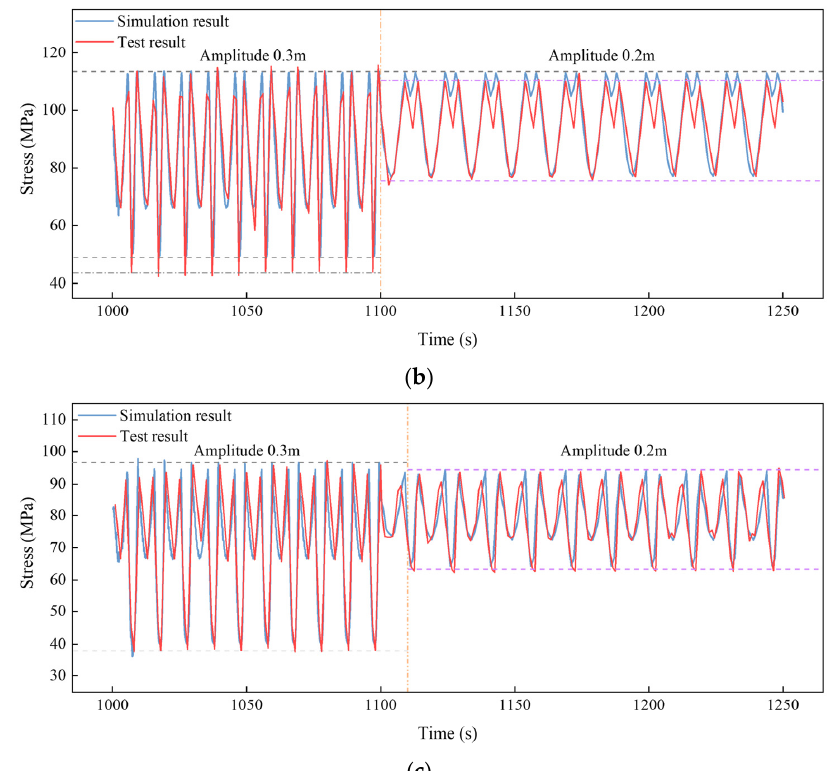
Figure 29. Time histories of the in-plane stress when the amplitude increased from 300 mm to 200 mm: ( a ) S2; ( b ) S5 and ( c ) S8.